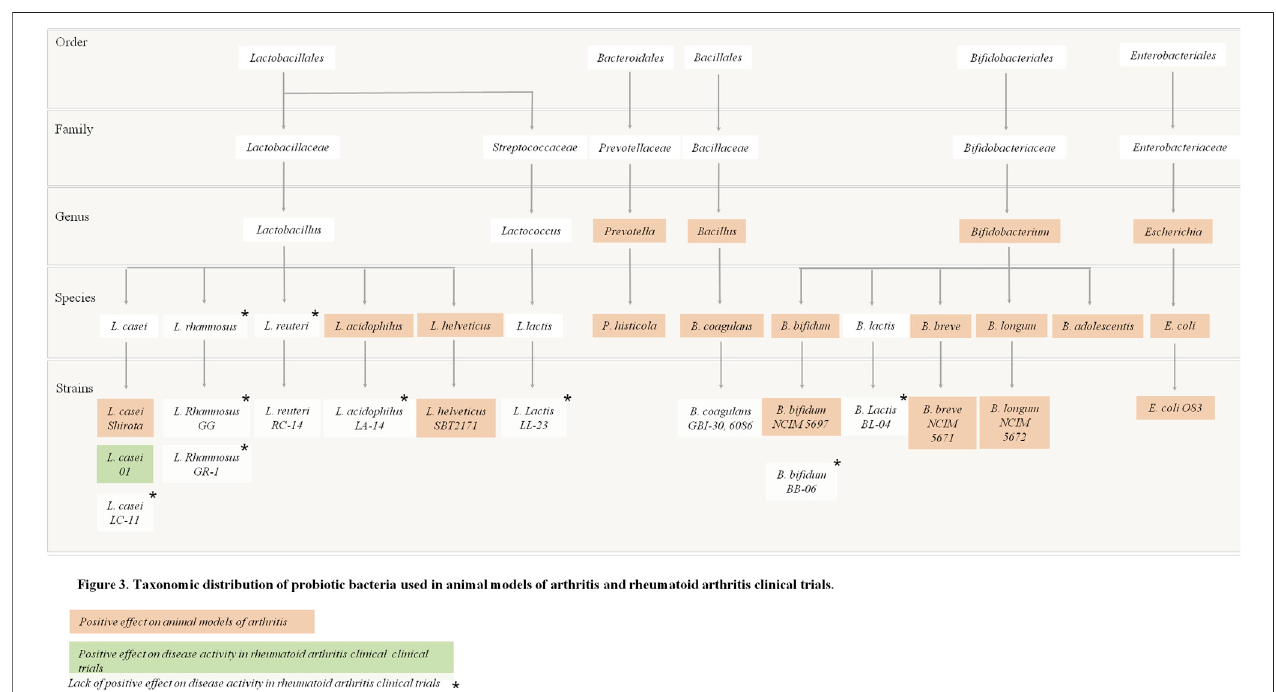
FIGURE 3 | Taxonomic distribution of probiotic bacteria used in animal models of arthritis and rheumatoid arthritis trials.